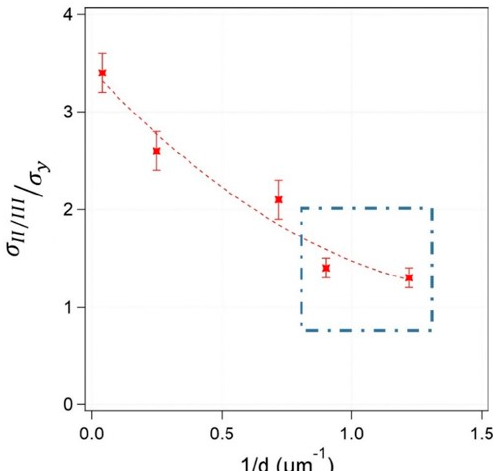
Figure 6. Evolution of the transition stress from work hardening stage II to stage III ( σ II/III ) normalized by yield strength as a function of 1/d for the five sintered samples. The two UFG samples are framed in blue.